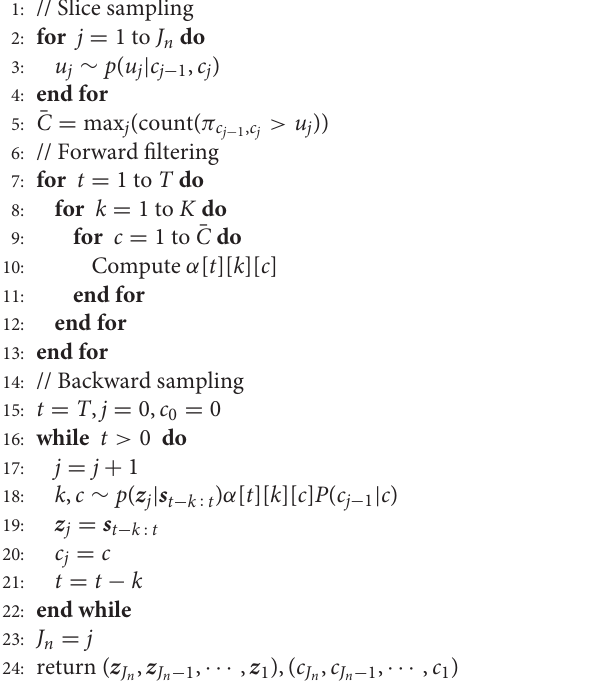
Algorithm 3: Forward Filtering–Backward Sampling